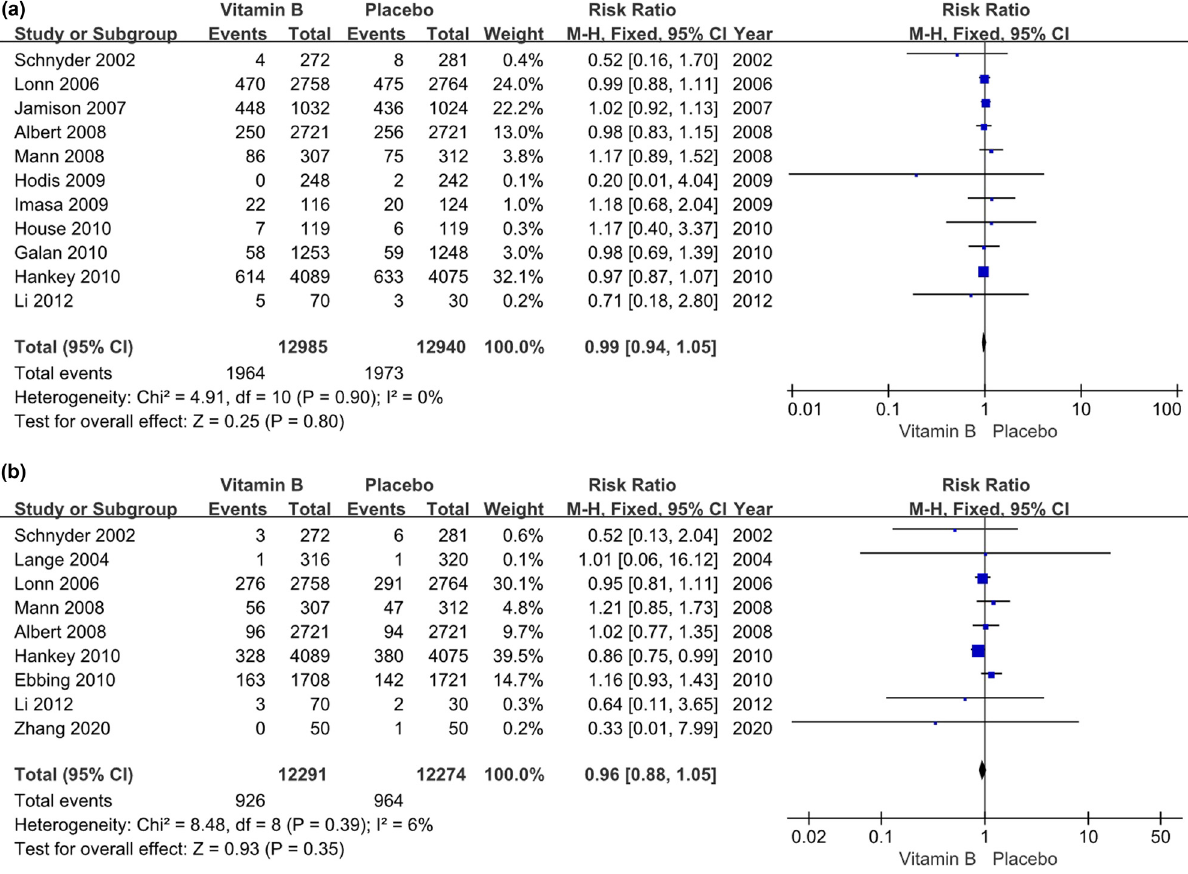
Figure 4: Forest plots showing the e ff ect of B vitamin supplementations on mortality: ( a ) total mortality and ( b ) cardiovascular death.